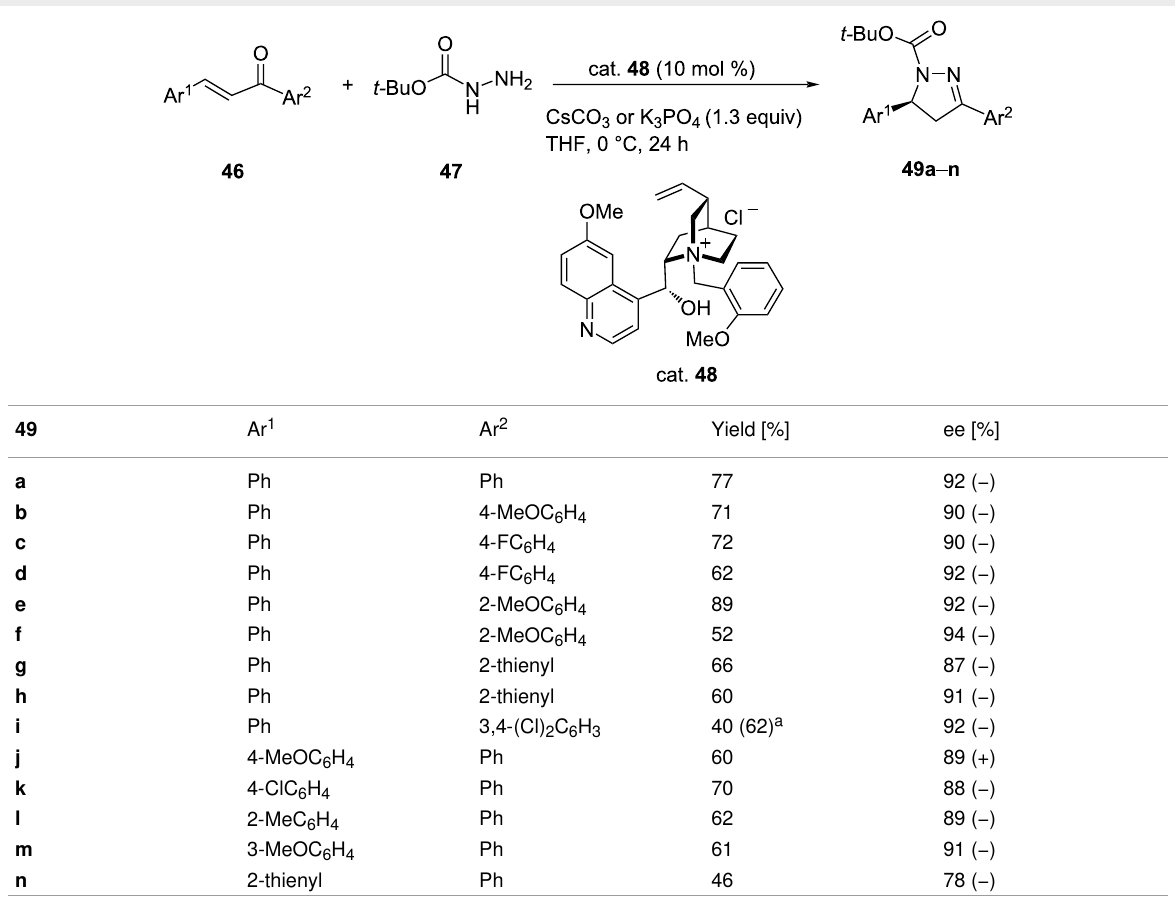
Table 10: Asymmetric aza-Michael addition for the formation of (S)-( − )-pyrazoline.